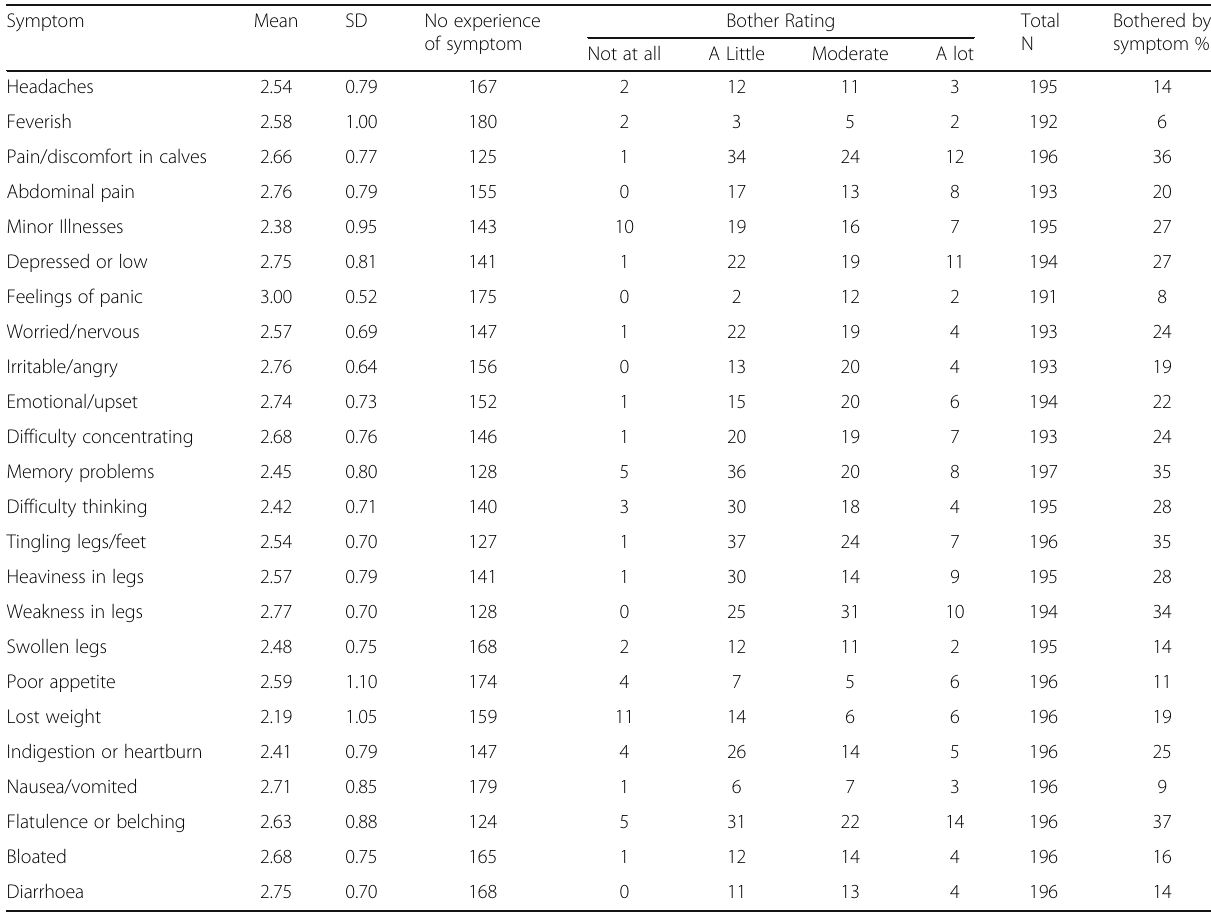
Table 5 AneurysmSRQ frequency scores and bother ratings for all items included in the six subscales, ordered by item number Symptom